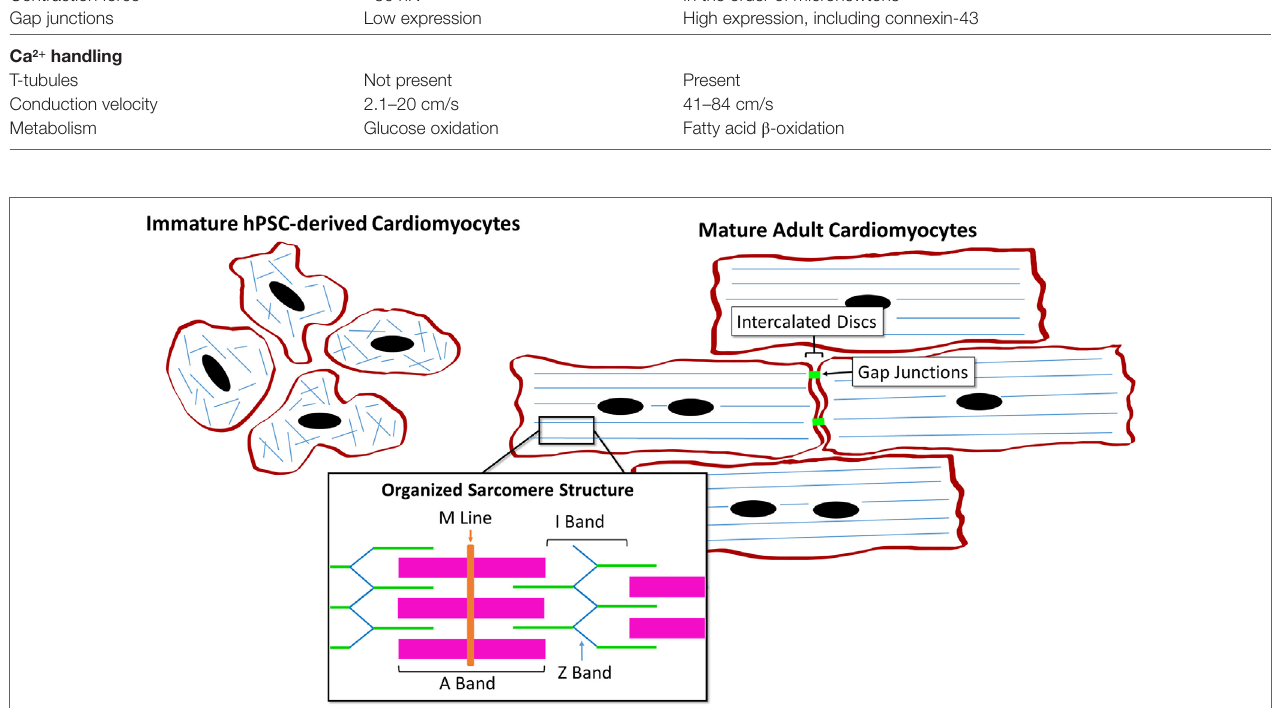
FiGURe 2 | Comparison of human pluripotent stem cell (hPSC)-derived CMs and adult CMs demonstrating the structural and organizational changes during maturation.